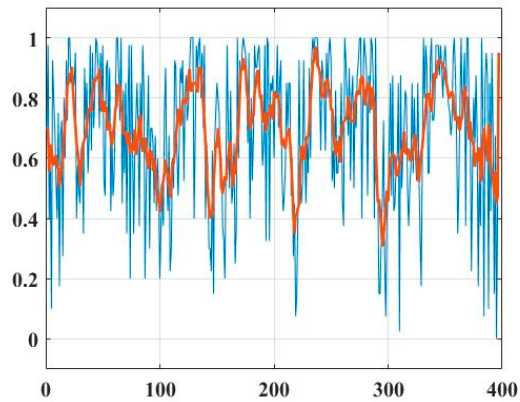
Figure 4. A digitally averaged representation of Tahafut al-Falasifa chunks.